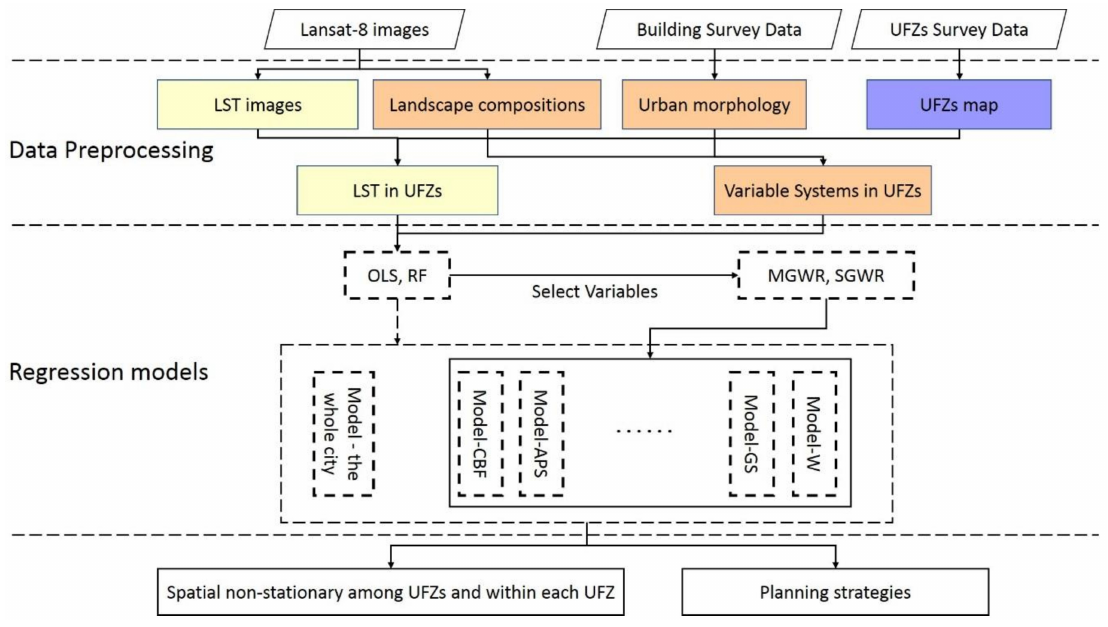
Figure 3. The methodological framework used in this